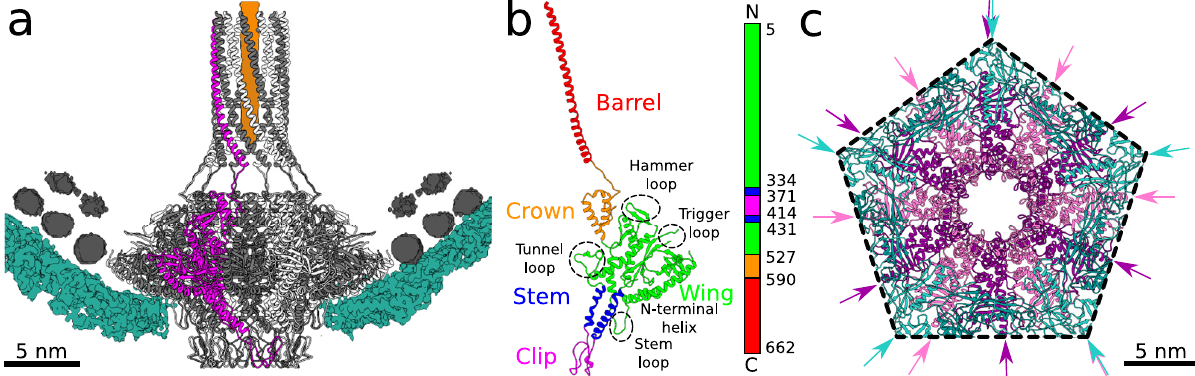
Fig. 4 | Structure of SU10 portal complex and its interactions with capsid. a Cartoon representation of portal complex embedded in capsid. One portal pro- teinisshowninmagenta,andtheremainingsubunitsinalternatingwhiteandgrey. The cryo-EM density ofthe capsidisshown in turquoise, and thatof DNAisshown in grey. The density of a putative end of the dsDNA genome or ejection proteins insidethe barrelofthe portalcomplexisshown in orange. The maps of capsid and DNAareshownat2 σ and4 σ ,respectively. b Cartoonrepresentationofasubunitof portal protein colored according to the domain composition. The domain